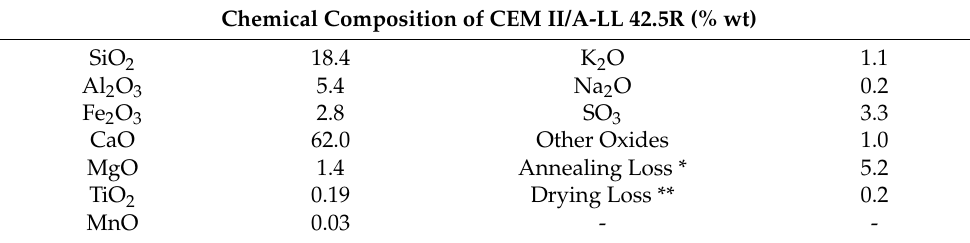
Table 2. Chemical Composition of CEM II/A-LL 42.5R.